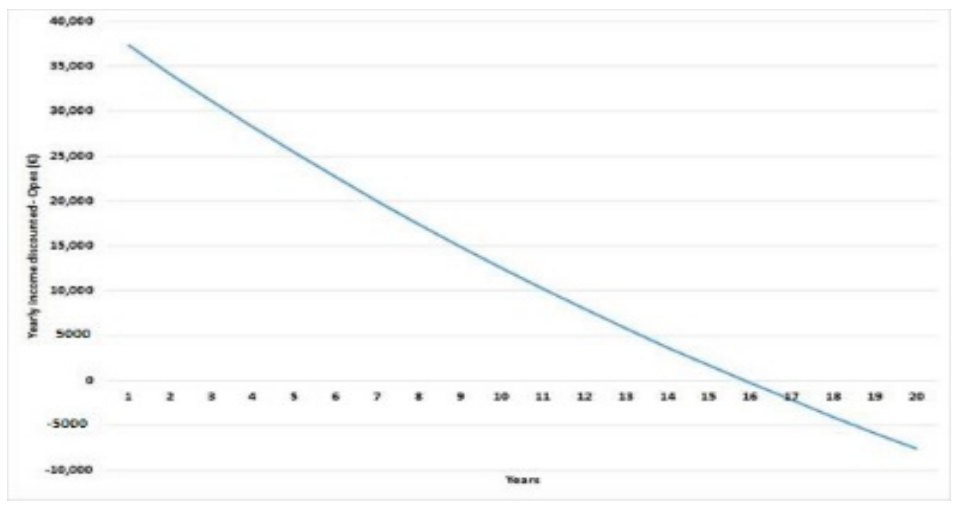
Figure 11. Yearly variable income minus Opex in the old turbine